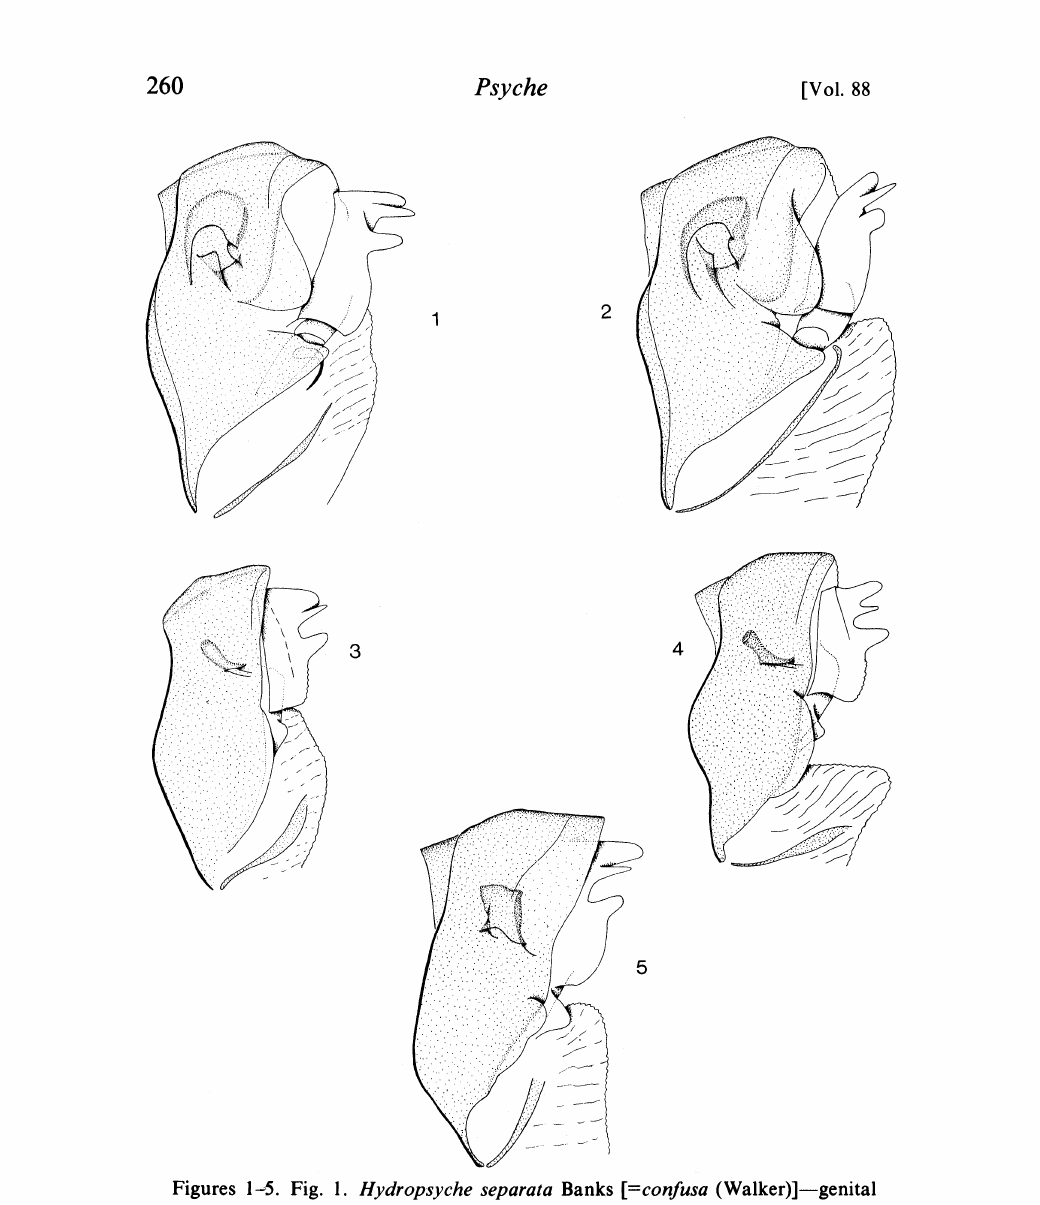
Figures 1-5. Fig. 1. Hydropsyche separata Banks [=confusa (Walker)]--genital segments of female, lateral aspect. Fig. 2. H. confusa (Walker)mgenital segments of female holotype, lateral aspect. Fig. 3. H. recurvata Banks [=alternans (Walker)] --genital segments of female, lateral aspect. Fig. 4. H. alternans (Walker)mgenital segments of female holotype, lateral aspect. Fig. 5. H. reciproca (Walker)--genital segments of female holotype, lateral